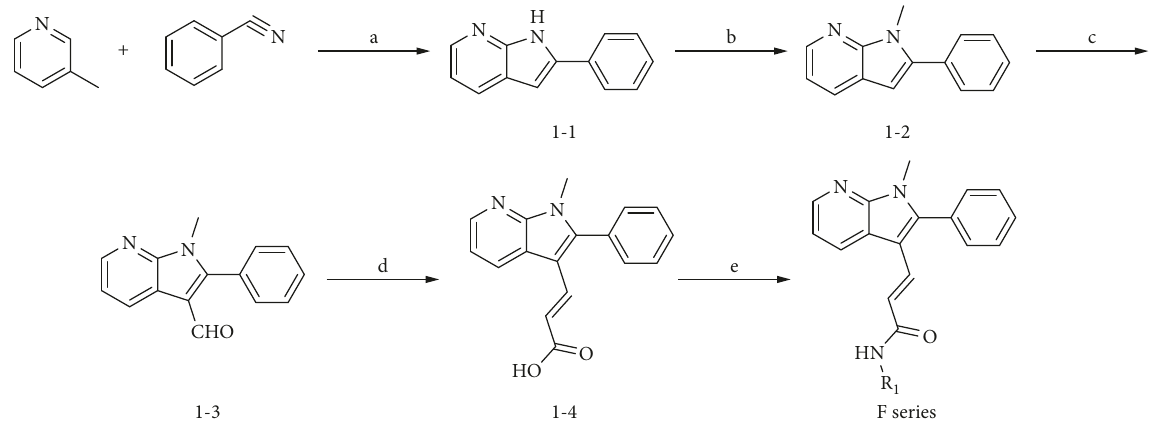
Scheme 1: Synthetic route of F series. a: LDA, THF, 0 ° C, 24h. malonic acid, Py, refluxed, 4h. e: EDCI, HOBT, triethylamine, rt,